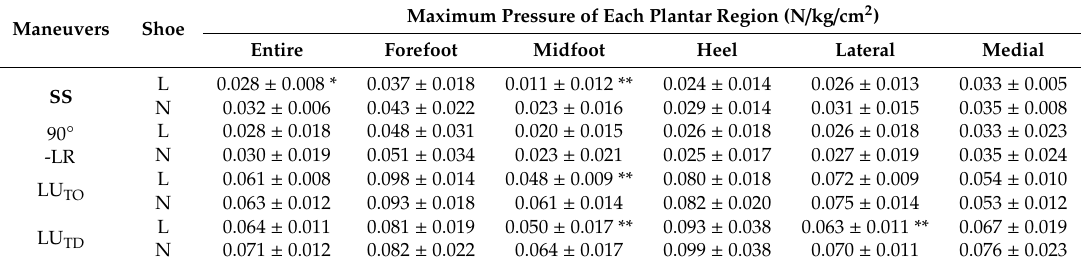
Table 2. E ff ect of di ff erent basketball shoes on maximum pressure of each plantar region